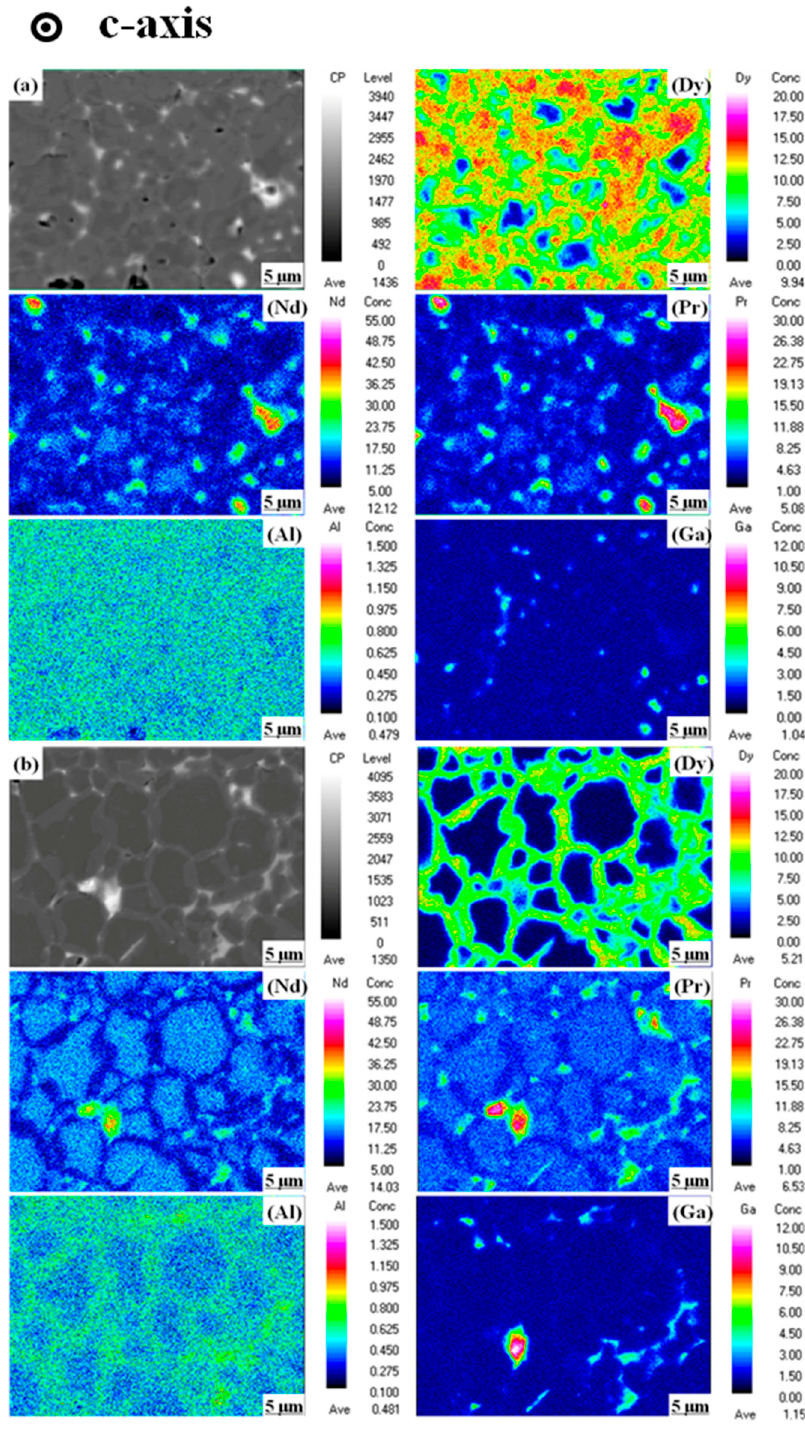
Figure 6. The EPMA mappings of the near-surface layer (perpendicular to c-axis): ( a ) Dy 70 Al 10 Ga 20 magnet; ( b ) (Pr 75 Dy 25 ) 70 Al 10 Ga 20